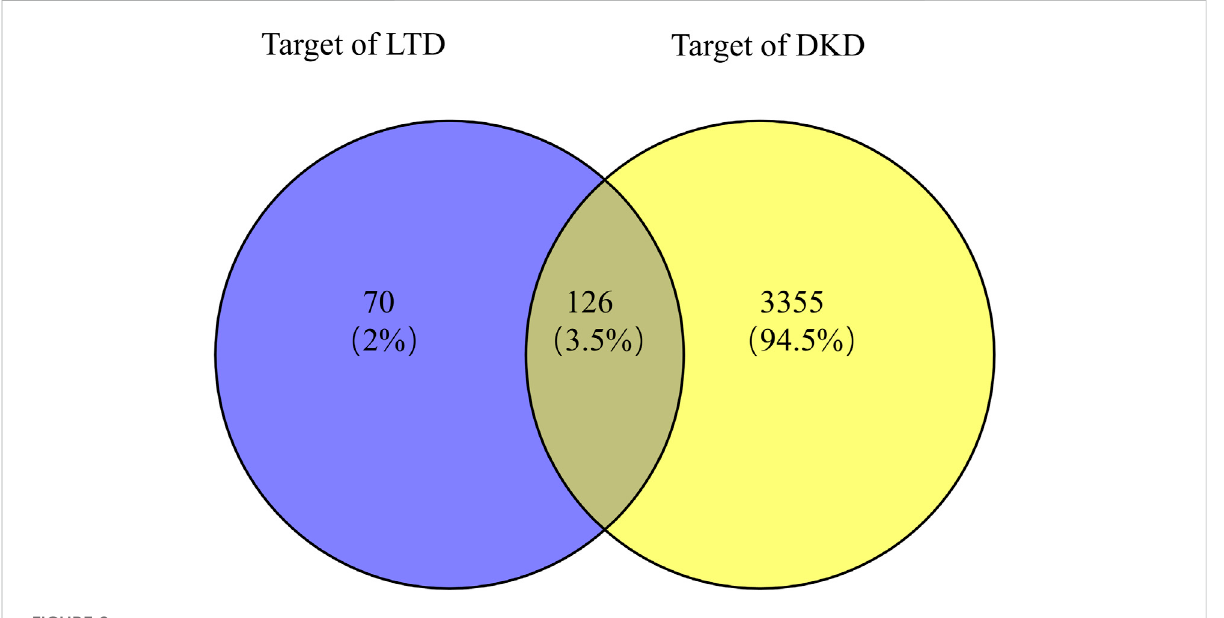
FIGURE 2 Venn diagram of the intersection target of LTD and DKD.